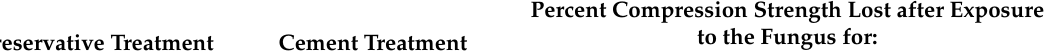
Table 3. Comparative decay resistance of untreated and preservative-treated pine wafers with and without cement infusion and exposed to Rhodonia placenta in a soil block test. Each value is the average of eight replicates, with high values representing extensive